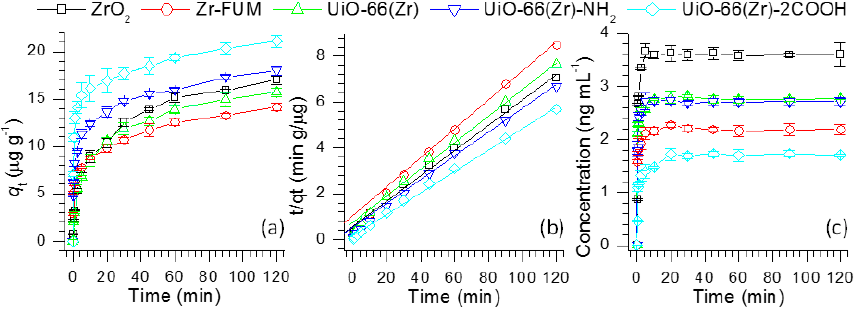
Figure 1. ( a ) Time profiles of verapamil adsorption over various Zr-based materials and ( b ) their derived pseudo-second-order kinetics plots of verapamil adsorption, and ( c ) time profiles of verapamil desorption from verapamil-adsorbed Zr-based materials.